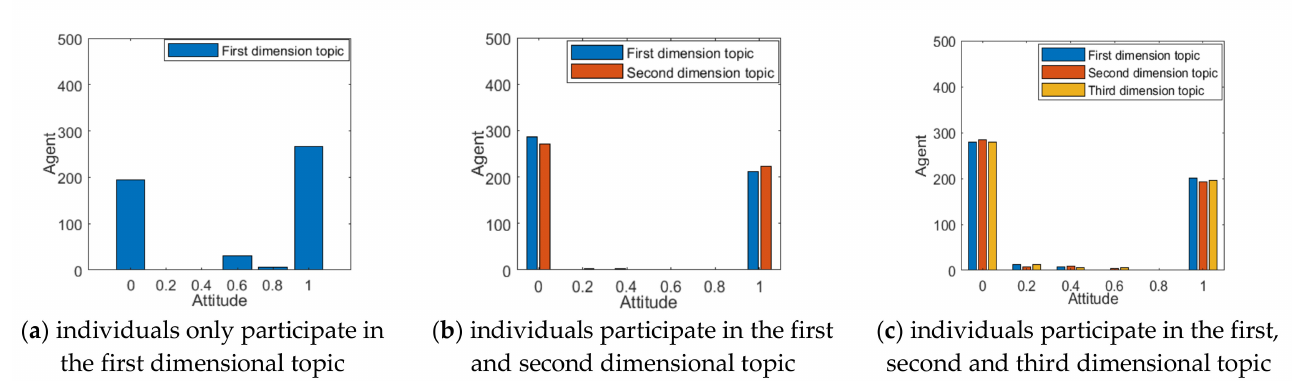
Figure 3. The distribution of group attitude when individuals participate in different topics.